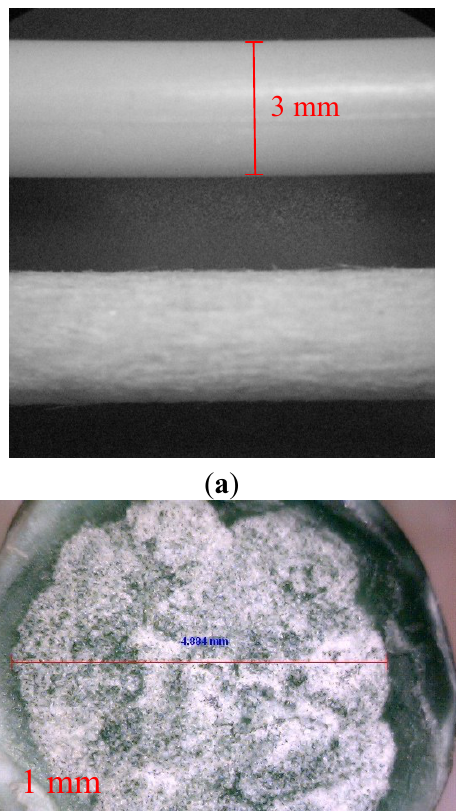
Figure 8. Micrographs of pultruded rods. ( a ) NEPTCO rods before (upper side) and after (bottom side) sandblasting; ( b ) POLYSTAL rods; ( c ) JONAM rods (cross-section surface); ( d ) JONAM rods after compression